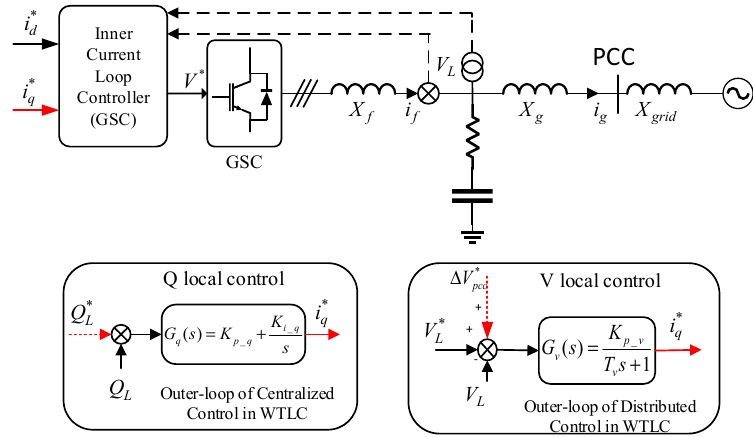
Figure 1. The control mode of the WT.